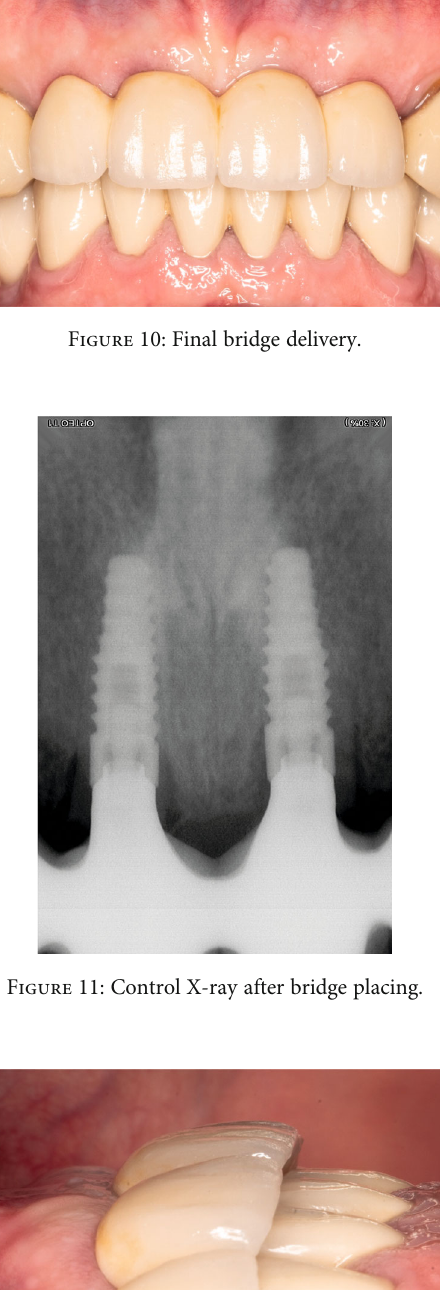
Figure 9: One-month follow-up, after high-speed handpiece reshaping of the shield exposure on 2.1.